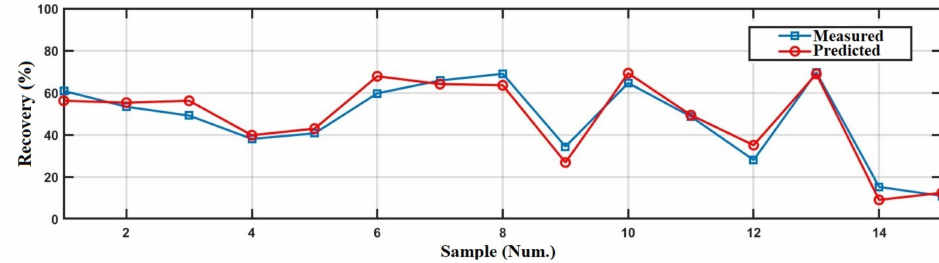
Figure 16. Comparison of measured and predicted values in the BPNN testing phase. Table 10. Descriptive statistics of errors between actual and BPNN predicted values for the test data.